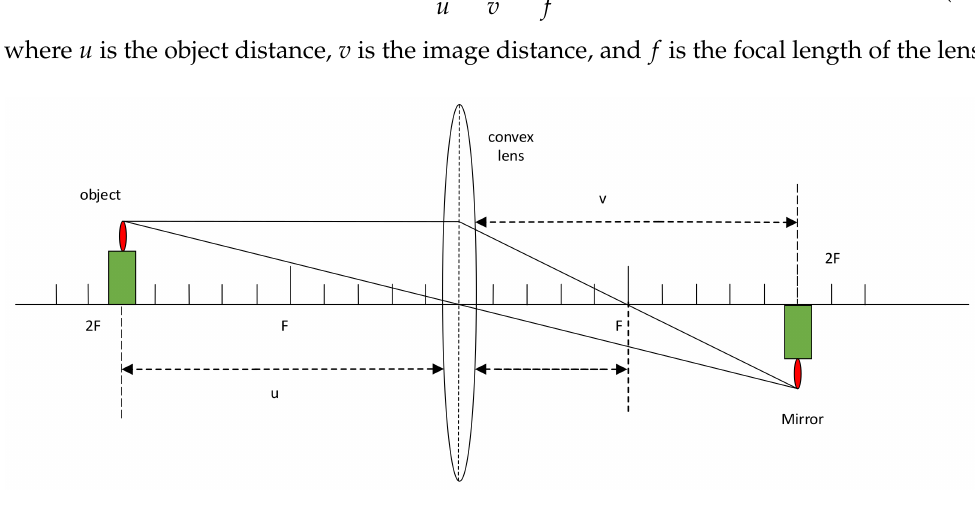
Figure 1. Schematic diagram of lens